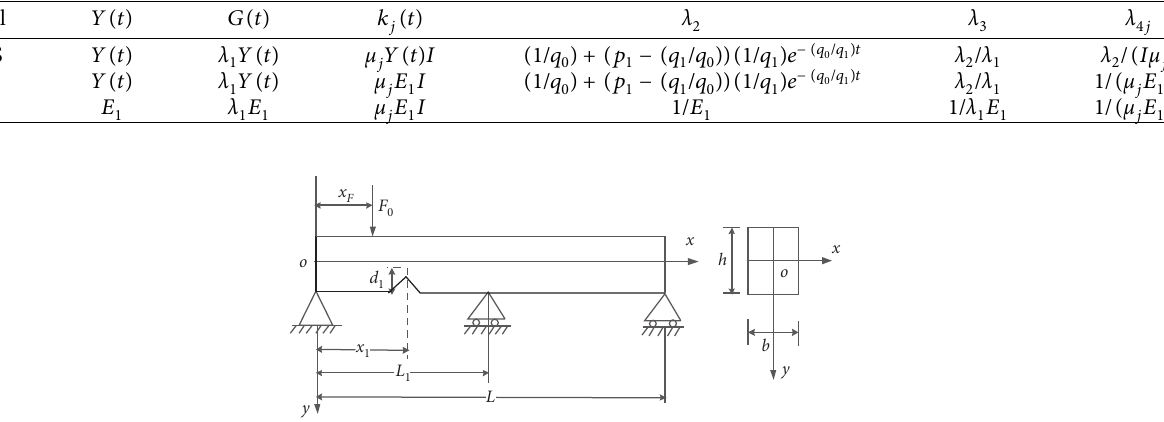
Table 1: Parameters of the three kinds of cracked beam models with open cracks.